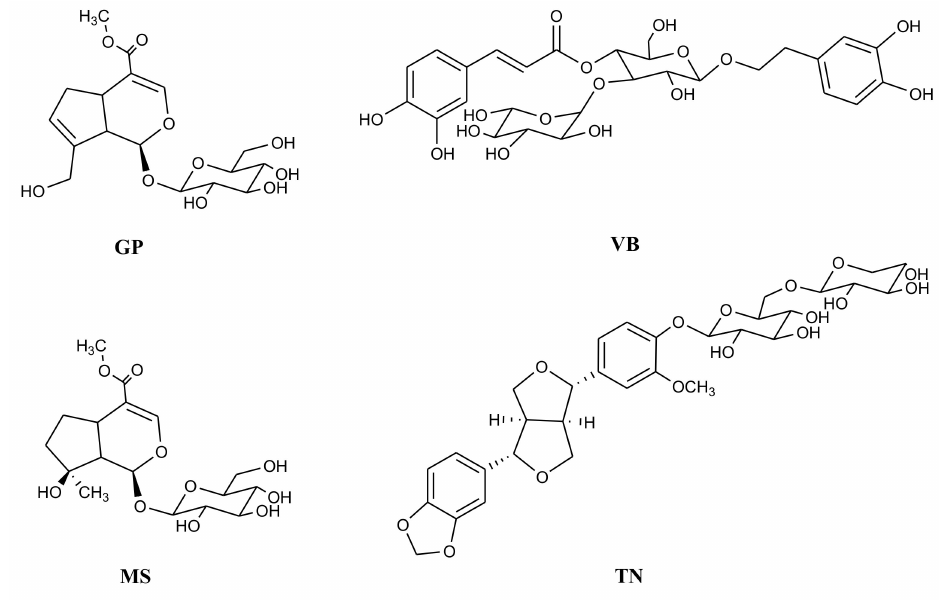
Figure 1. Bioactive compounds from Castilleja tenuiflora Benth. Genoposide ( GP ), mussaenoside ( MS ), verbascoside ( VB ) and tenuifloroside ( TN